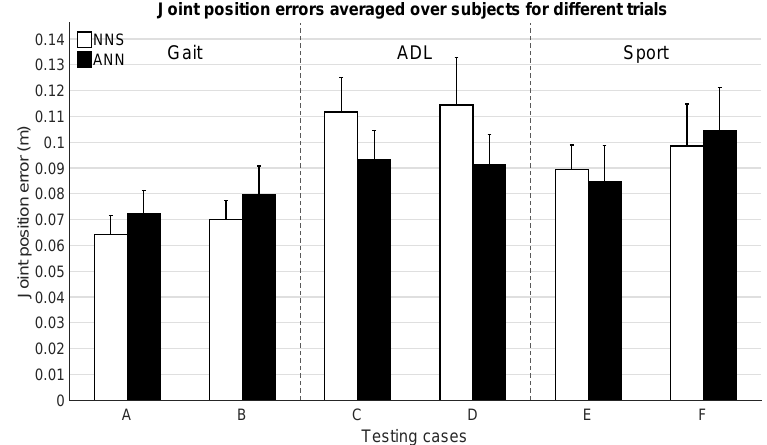
Figure 7. Mean (over all six subjects) and standard deviation (between the six subjects) of joint position errors for different testing cases, as described in Table 3.